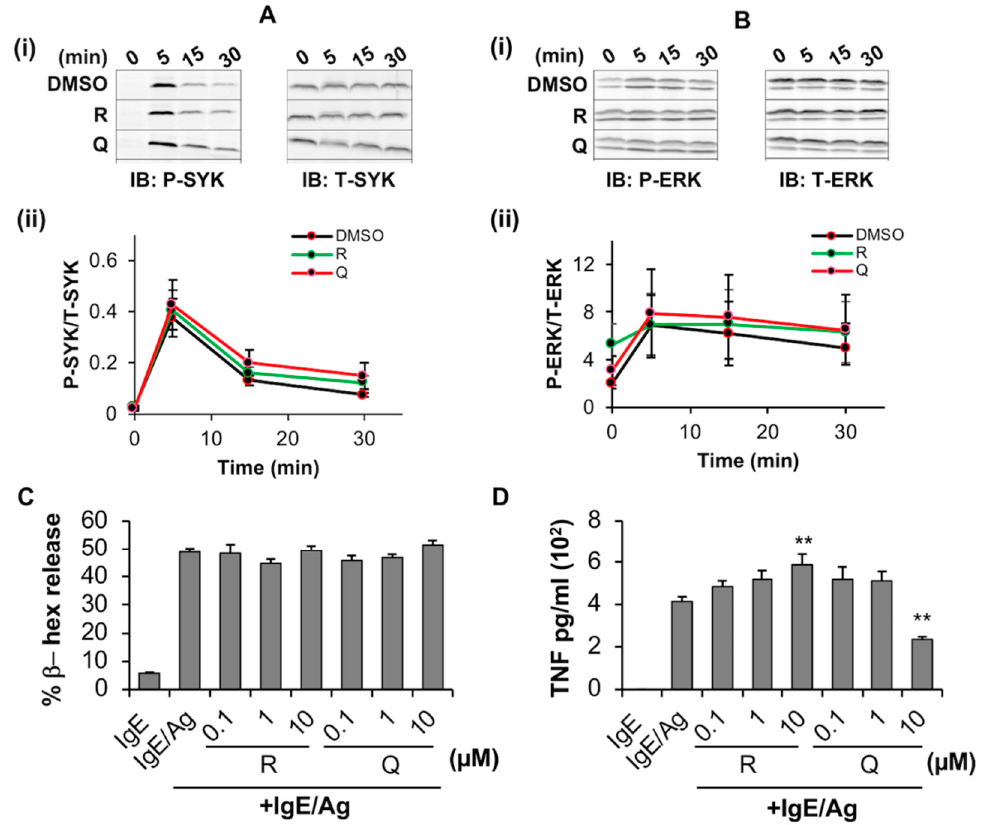
Figure 4. Effects of resveratrol and quercetin on SYK/ERK phosphorylation and degranulation by BMMC. ( A , B ) BMMC were treated with 10 µM resveratrol (R), quercetin (Q), or an equal volume of DMSO or media and incubated for 24 h while simultaneously exposed to 100 ng/mL of anti-DNP IgE. Activation of the IgE receptor was then induced by exposure to 100 ng/mL DNP-BSA for indicated times before lysis. Lysates were then probed via Western blot with antibodies towards phosphorylated (P) and (T) total SYK (Ai) and ERK1/2 (ERK, Bi). Densitometric analysis of the ratio between “P” and “T” stains are shown for SYK (Aii) and ERK (Bii) (n = 3). ( C ) BMMC were sensitized with anti-DNP IgE overnight and simultaneously treated with 0.1, 1 and 10 µ M resveratrol (R) or quercetin (Q) for 24 h followed by stimulation with DNP-BSA and measuring the % release of β -hex ( D ). BMMC were sensitized with anti-DNP IgE overnight and treated with 0.1, 1 and 10 µ M resveratrol (R) or quercetin (Q) for 24 h followed by stimulation with DNP-BSA and measuring the % release of TNF. n = 3. p value < 0.01 (**) are relative to